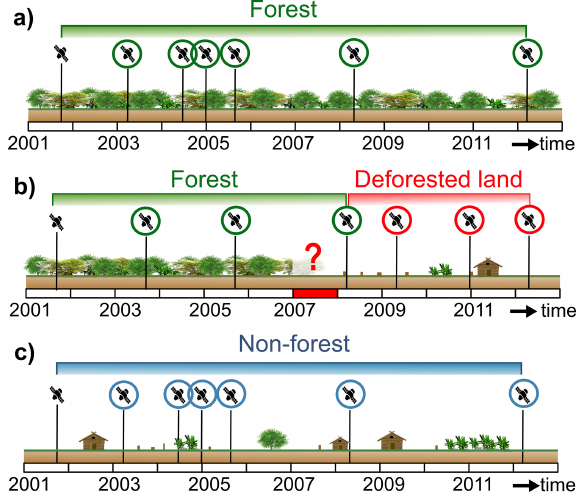
Figure 6. Schematic overview of the three considered forest cover scenarios in © Google Earth. The satellite icons signal the avail- ability of a © Google Earth image, and the colored circles indicate whether we can potentially observe recent landslides in the con- cerned image. Panel (a) shows the forest scenario, wherein each landslide observed in these areas is linked to forest cover. Panel (b) shows the deforestation scenario, wherein only landslides observed starting from the second © Google Earth image after the year of deforestation are considered to be linked to deforestation (in other words, we can only observe deforestation-induced landslides in im- agery that is encircled in red on the figure). Hence, in this illustrated example, we cannot attribute landslides from the 2008 imagery to deforestation, as we cannot be sure that these landslides happened before or after the 2007 deforestation. Note that we do not know the exact moment of deforestation, only the year (indicated with the red bar) is reported. Panel (c) shows the non-forest scenario, wherein every landslide observed in these regions is linked to non-forest ar-